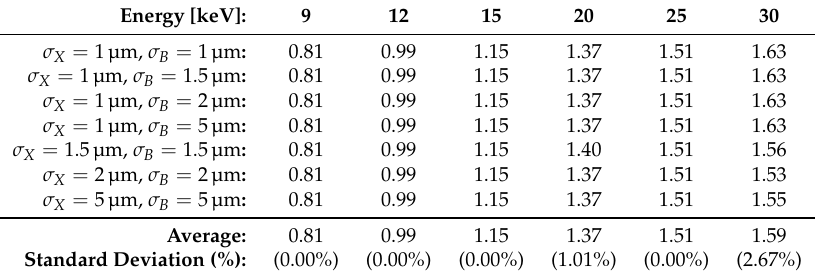
Table A1. Diffraction efficiency, relative to the 12keV value for RADDOSE-3D simulations, of all simulated data sets based on our control dose maps that included Compton scattering but excluded PE escape. The data show minimal variation with beam and crystal size.